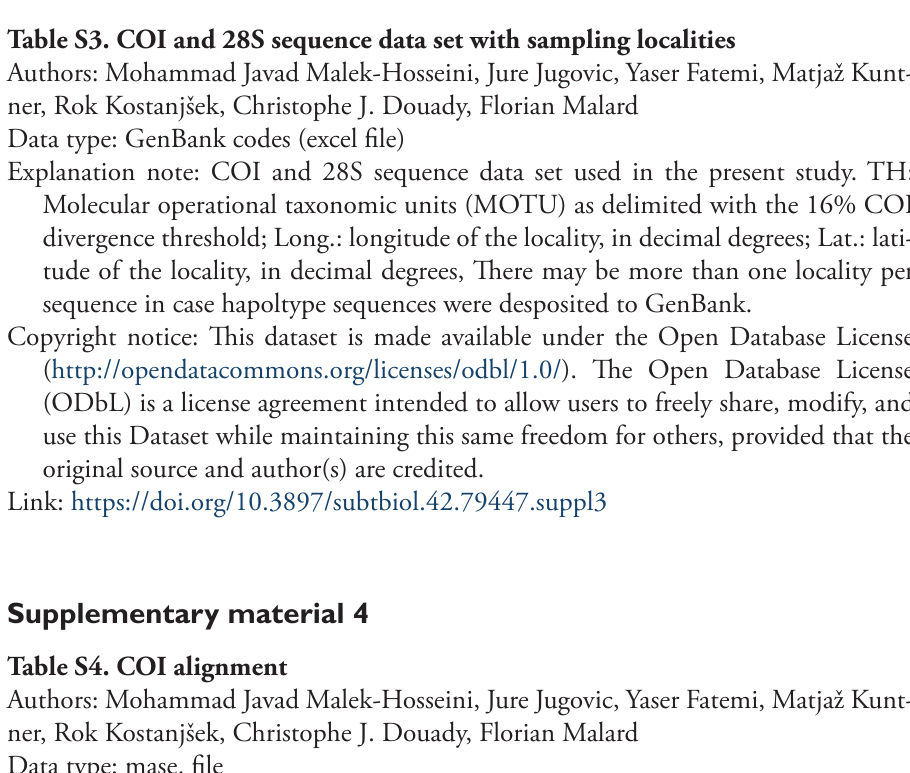
Table S3. COI and 28S sequence data set with sampling localities